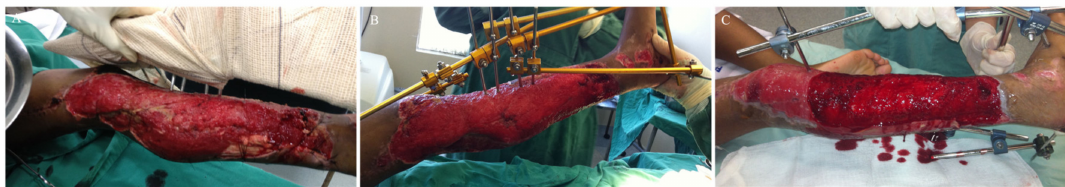
Figure 4. ( A ) Aspect of the leg on day 4. ( B ) Aspect of the leg on day 12. ( C ) Aspect of the leg on day 30, when half-pin external fixator was removed and an Ilizarov circular frame was applied to hold the distal tibia in place until bone